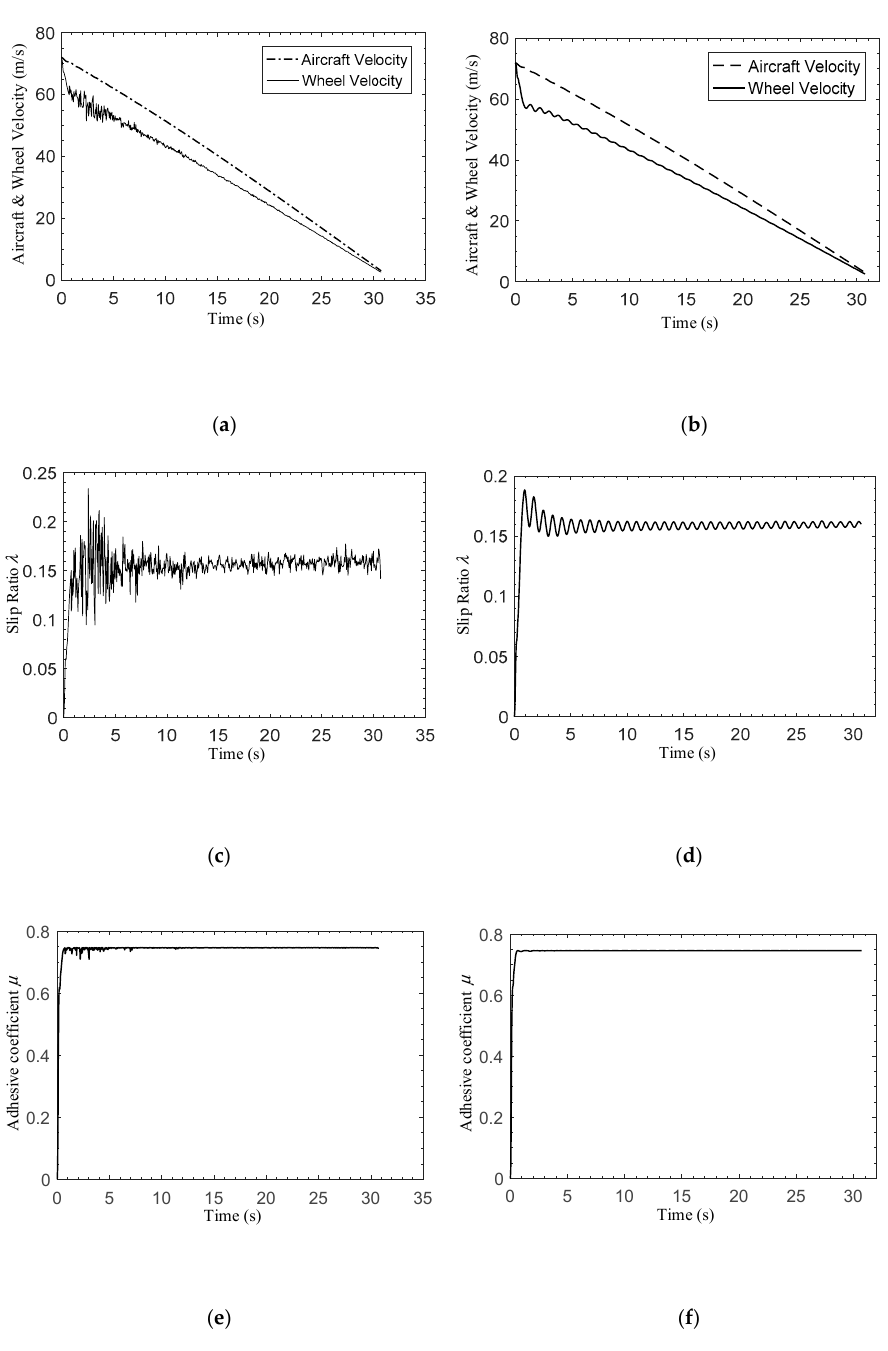
Figure 10. Slip ratio control performance of the ABS controller under dry runway conditions. ( a ) Aircraft velocity and wheel velocity in PID control; ( b ) aircraft velocity and wheel velocity in the proposed control method; ( c ) slip ratio in PID control; ( d ) slip ratio in the proposed control method; ( e ) adhesive coefficient between wheel and runway in PID control; (f) adhesive coefficient between wheel and runway in the proposed control method;.